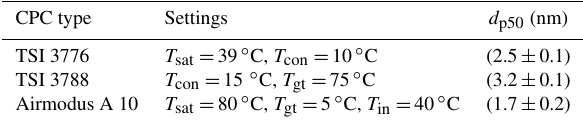
Table 2. Results of the cutoff diameter measurements with Ag seed particles for the three types of used particle counters and the cor- responding settings for the measurements. For the TSI instruments we used the standard manufacturer